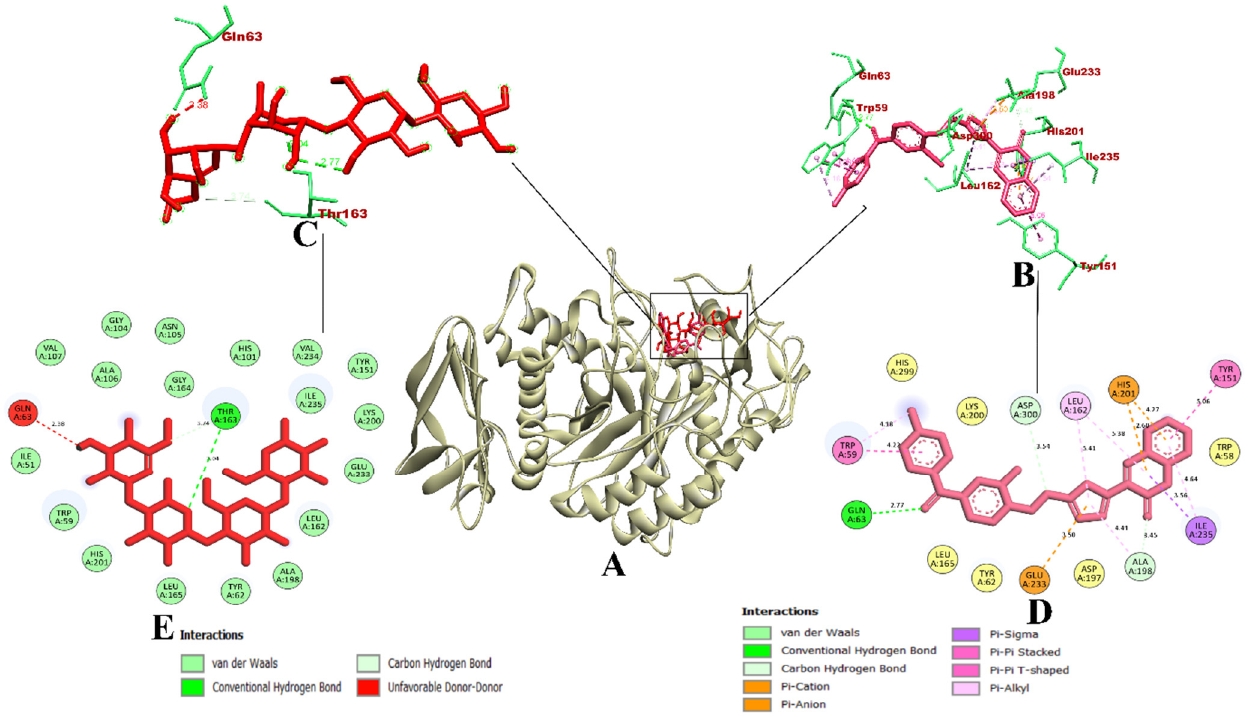
Figure 2. Visualization of binding interaction of CD-59 (magenta) and acarbose (red) with α -amylase; ( A ) 3D structure of α -amylase with bound CD-59 and acarbose in the binding pocket, ( B ) 3D representation of CD-59 binding interactions, ( C ) 3D representation of acarbose binding interactions, and ( D ) 2D representation of CD-59 binding interactions, and ( E ) 2D representation of acarbose binding interactions. Colored: bound residues, yellow: surrounding residues.